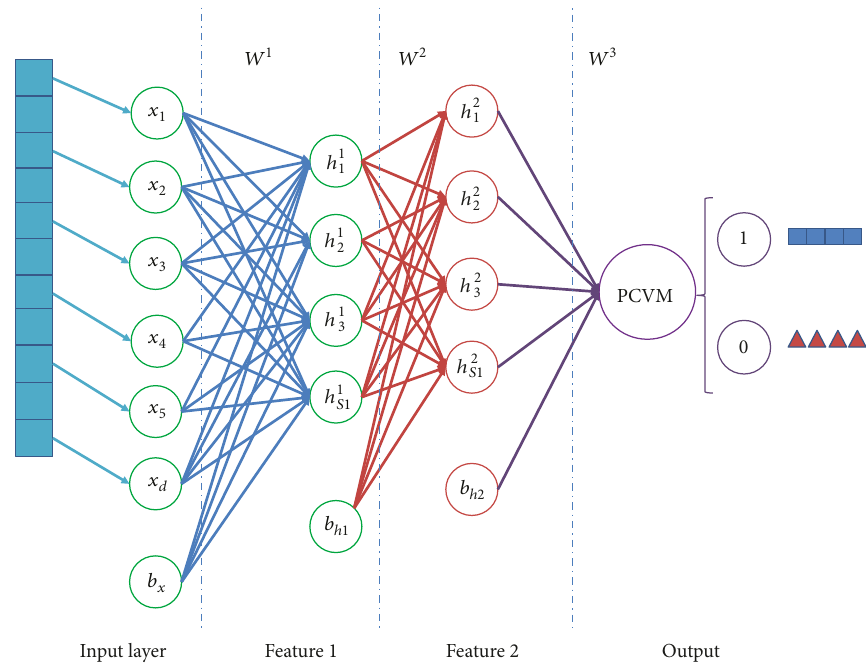
Figure 1: Stacked sparse autoencoder with two hidden layer